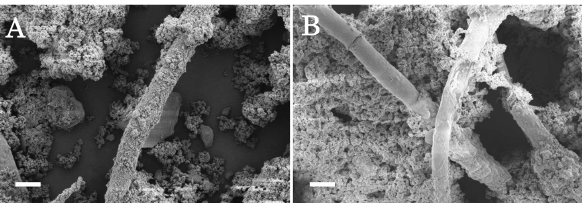
Figure 5. Scanning electron microscopy images of the green algae in site O (a) and the brown algae in site A (b) taken in September 2013. Scale bars indicate